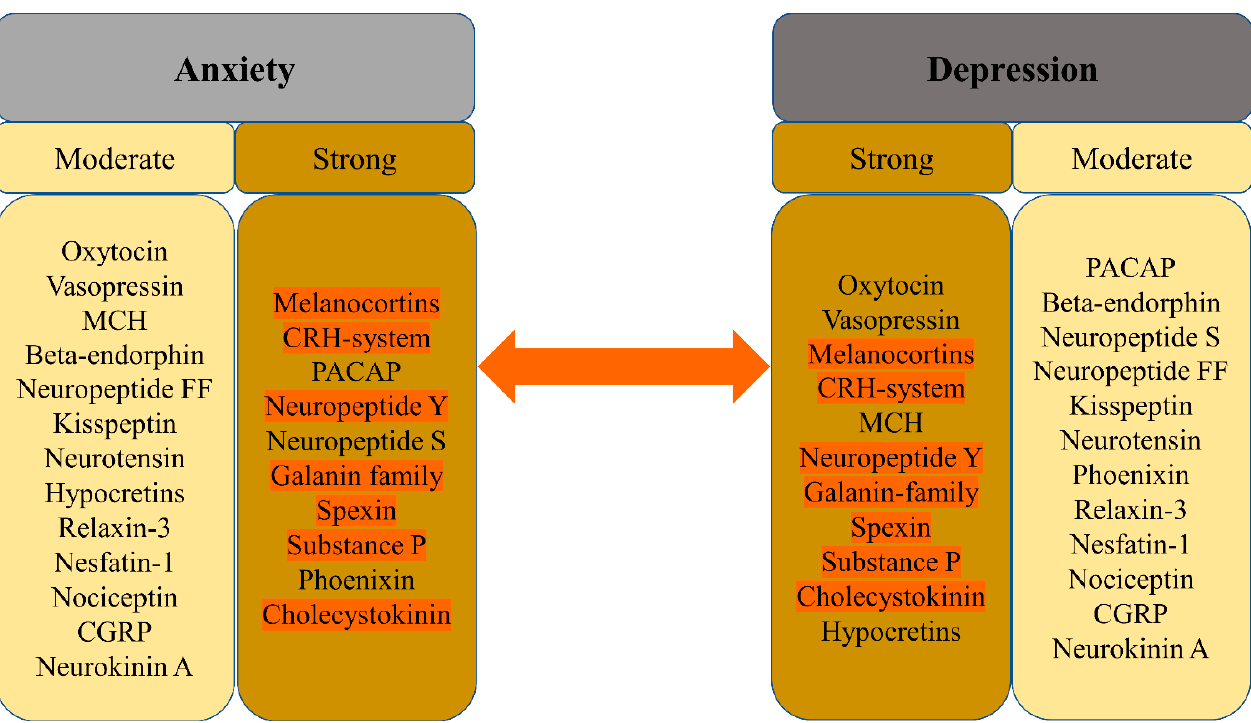
Figure 1. Association of neuropeptides with anxiety and depression based on evidence in research.